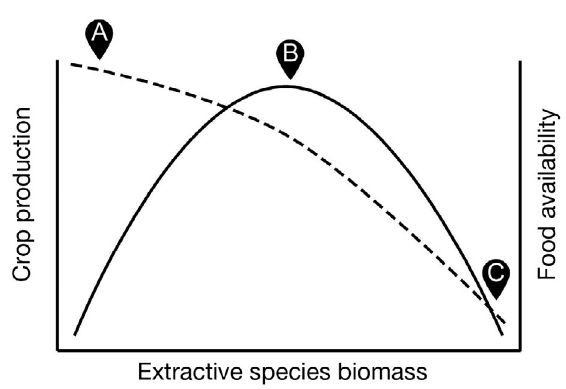
Fig. 5. Conceptual diagram of the effects of increasing ex- tractive species biomass on integrated multi-trophic aqua- culture (IMTA) farm profitability (crop production) and sustainability (availability of particulate organic fish waste, OFW). Point A represents existing open water IMTA farm conditions, at which the relatively low biomass of extrac- tive species results in sub-maximal crop production (solid line) and low OFW depletion (dashed line). Point B corre- sponds with the production carrying capacity of the extrac- tive species, which occurs when crop production is limited by the available food supply, including OFW. At Point C, the high stocking biomass provides efficient waste extrac- tion at the expense of crop production and profitability. The OFW availability line is shown as a curve owing to the expected feedback effects of increasing IMTA structures on current speed reduction and the resulting